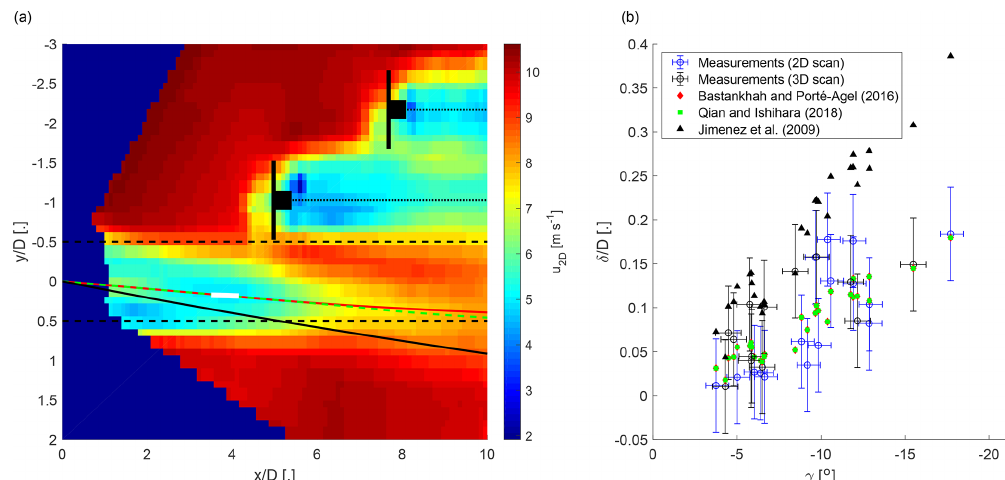
Figure 9. Panel (a) shows an example from the wake-steering cases with a mean yaw offset of γ = 18 ◦ . The mean longitudinal velocity field is shown as a colour image. The predicted wake deflection of the Bastankhah and Porté-Agel (2016) model is shown as a solid red line, the Qian and Ishihara (2018) model is shown as a dashed green line, and the Jiménez et al. (2009) model is shown as a solid black line. The solid white line shows the result of the wake-centre detection with a correlation coefficient larger than 0.99 (see Sect. 2.3.3). The dashed black line indicates the rotor area of T2. Turbines 3 and 4 are stylized in black, and a dotted black line is a visual aid to indicate the downwind direction. Panel (b) shows the normalized wake deflection at x/D = 4 as a function of the yaw angle for the wake-steering cases with a successful wake detection and a model prediction at x/D = 4. The measurements are shown in blue for the 2D scans and in black for the 3D scans. The error bars are based on the errors found between WindIris and WindCube (Sect. 3.1). The analytical models of Jiménez et al. (2009; black triangles, Eq. A25), Bastankhah and Porté-Agel et al. (2016; red diamonds, Eq. A7), and Qian and Ishihara (2018; green squares, Eq. A18) are plotted for each